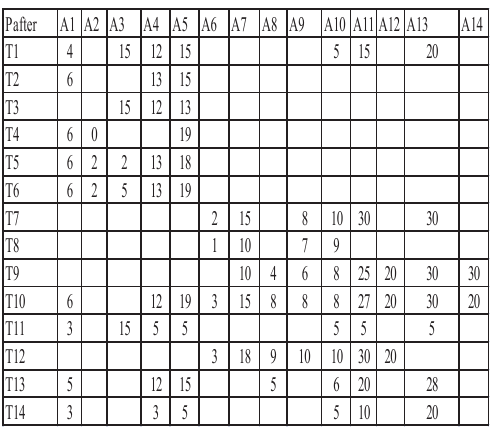
Table 3: Probability Of A Loss After Assessing With Technique T